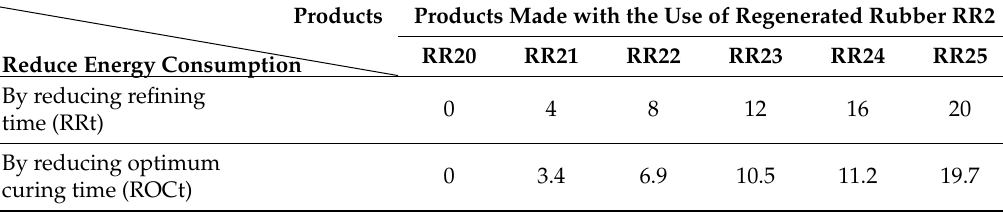
Table 8. Reducing energy consumption in making products with the use of regenerated rubber RR2, %.